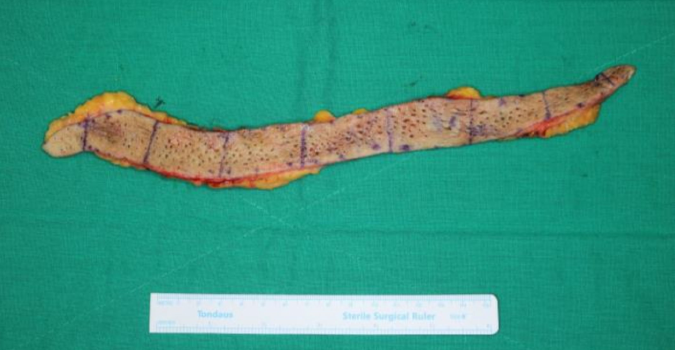
Figure 2. The nevus comedonicus specimen measuring 30 × 2 cm.